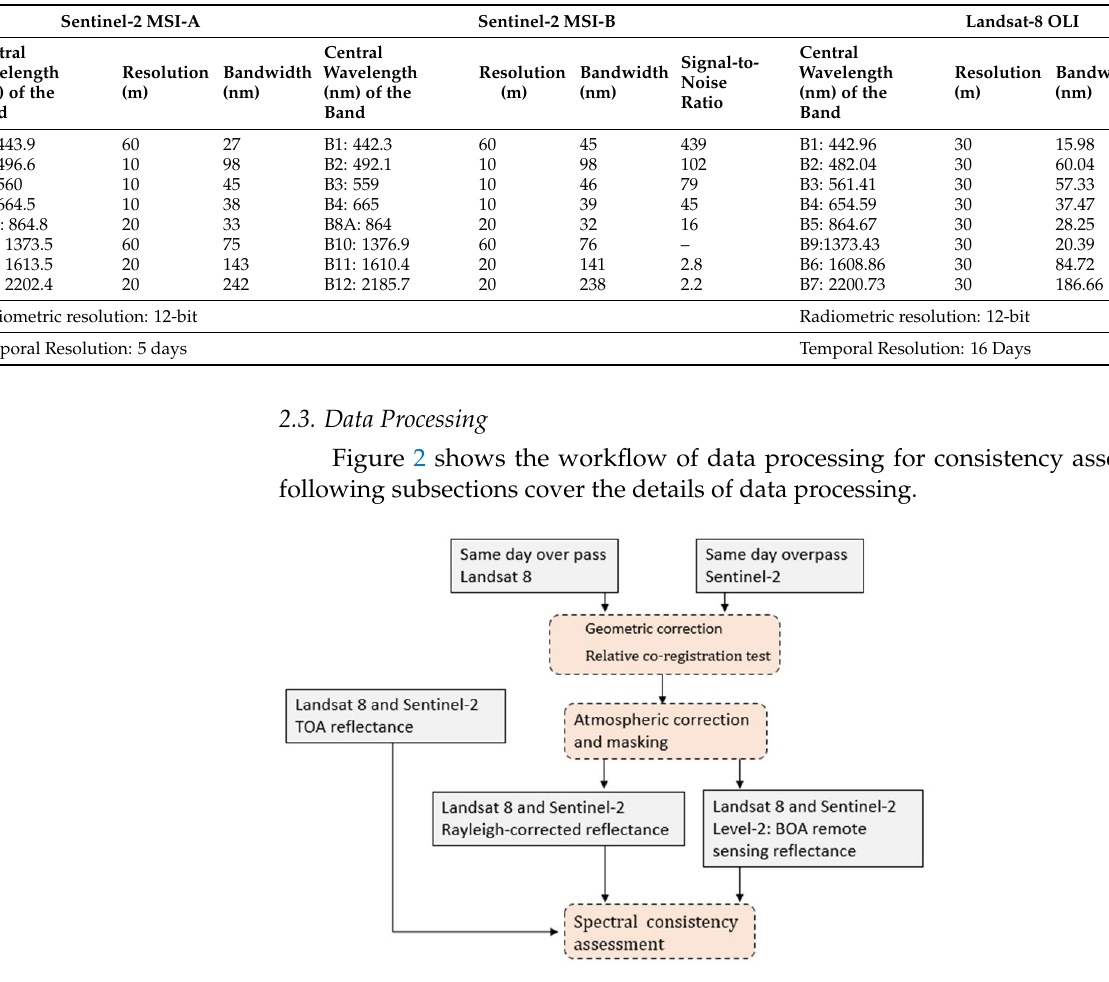
Table 1. Sentinel 2 MSI A/B and Landsat-8 OLI sensor characteristics.